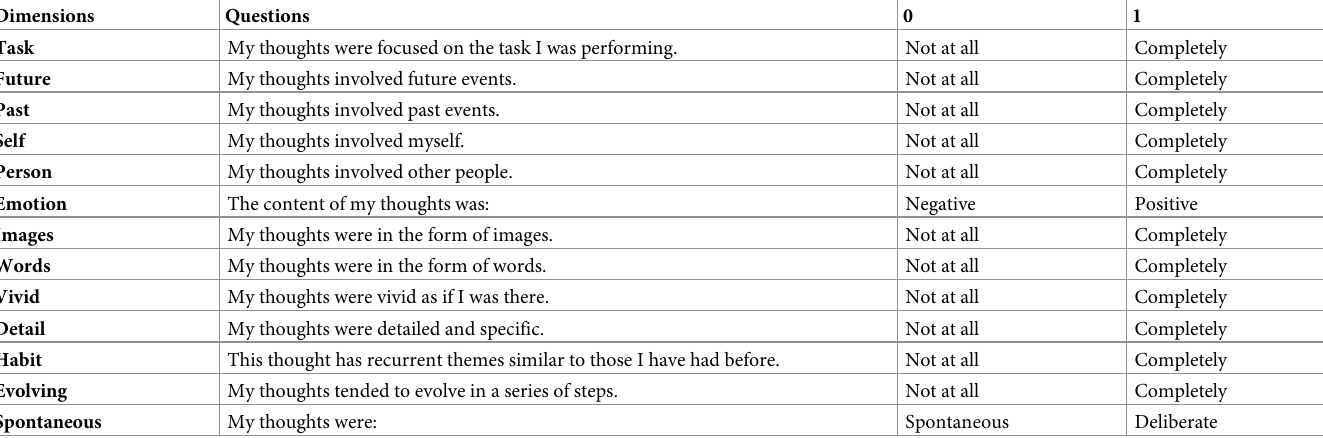
Table 1. Multi-Dimensional experience sampling questions used this experiment.